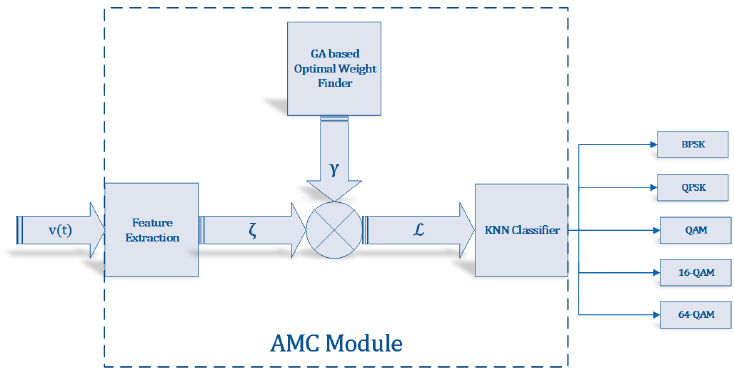
Figure 2. Proposed AMR